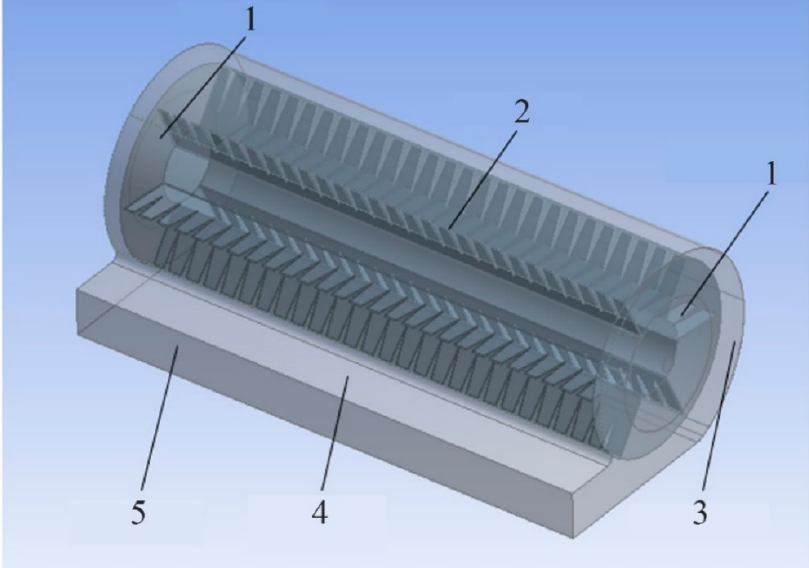
Figure 8. Schematic diagram of simplified model. 1. Inlet. 2. Rotating area. 3. The surface of film removal area. 4. Static area. 5. The surface of film conveying port. Table 1. The main parameters of the simplified model. Parameters Value Curve radius of diversion shell R 1 , R 2 , R 4 , R 5